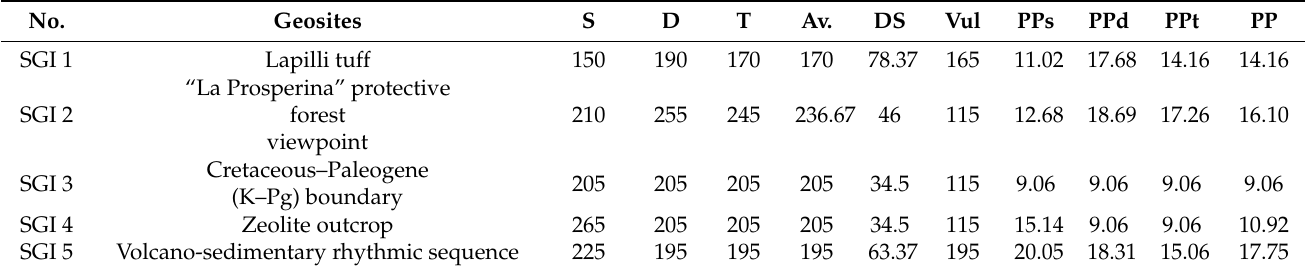
Figure 5. Geoeducational route along with the university campus. Access to geoeducational route: ( A ) access from guardhouse PARCON, ( B ) access from Perimetral track, ( C ) access from “La Prosperina” protective forest, and ( D ) access from Bomberos avenue. Table 6. The overall framework of the assessment of sites of geological